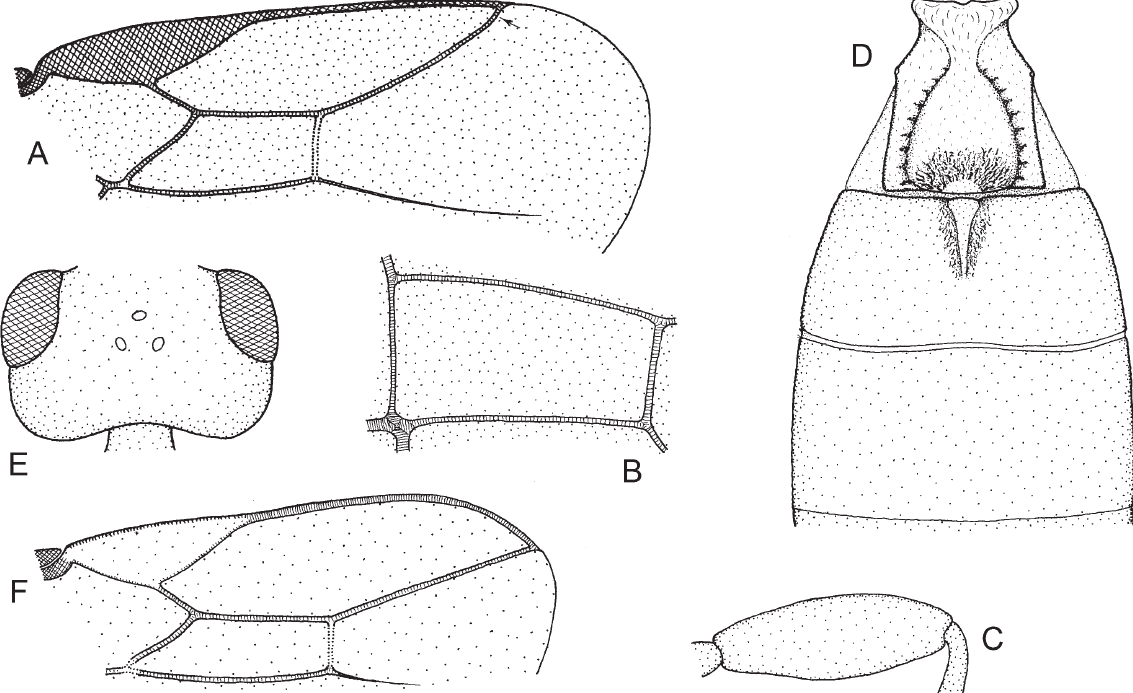
Fig. 30. — A-E . Bracon ( Lucobracon ) turolus Papp, 1984, ♀ holotype. A . Distal part of right forewing. B . First discal cell of right forewing. C . Hind femur. D . Tergites 1-3. E . Head in dorsal view. — F . Bracon ( Glabrobracon ) orbus Papp, 1981, ♀ holotype, distal part of right